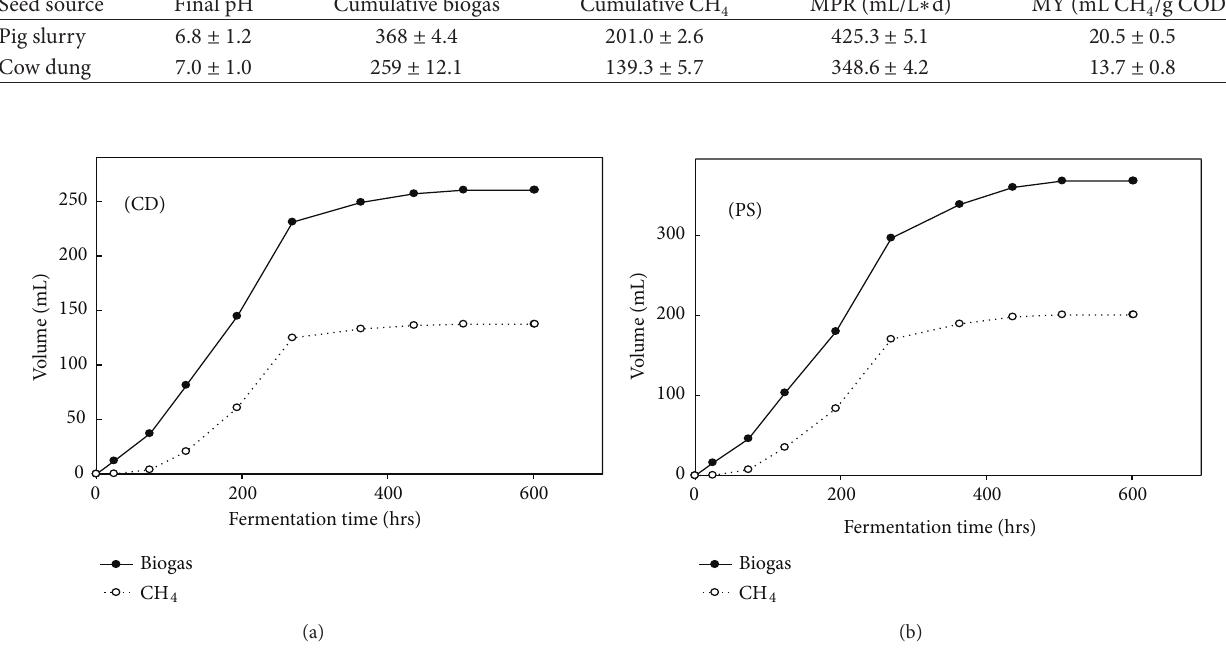
Figure 3: Batch CH 4 fermentation profiles of pig slurry (PS) and cow dung